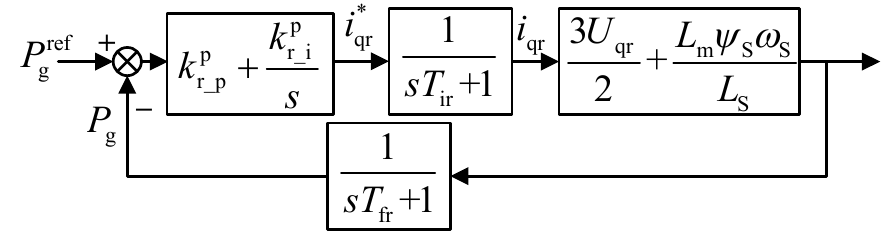
Figure 6. Reactive power control loop of the DFIG. Figure 5. Active power control loop of the DFIG. Figure 5. Active power control loop of the